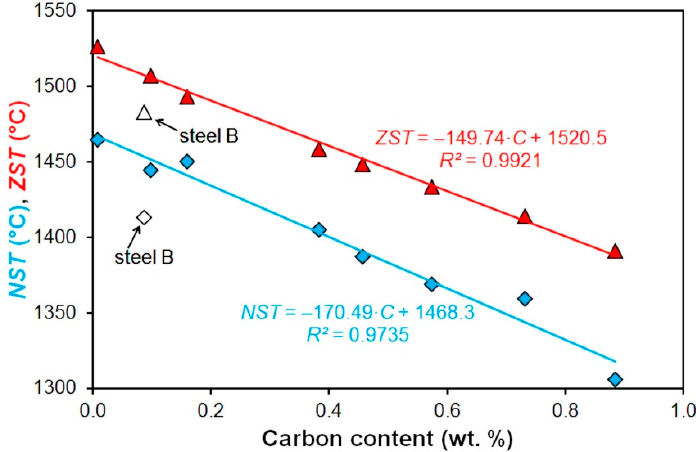
Figure 3. Comparison of the measured nil-strength temperatures and calculated zero-strength temperatures of the investigated steels.